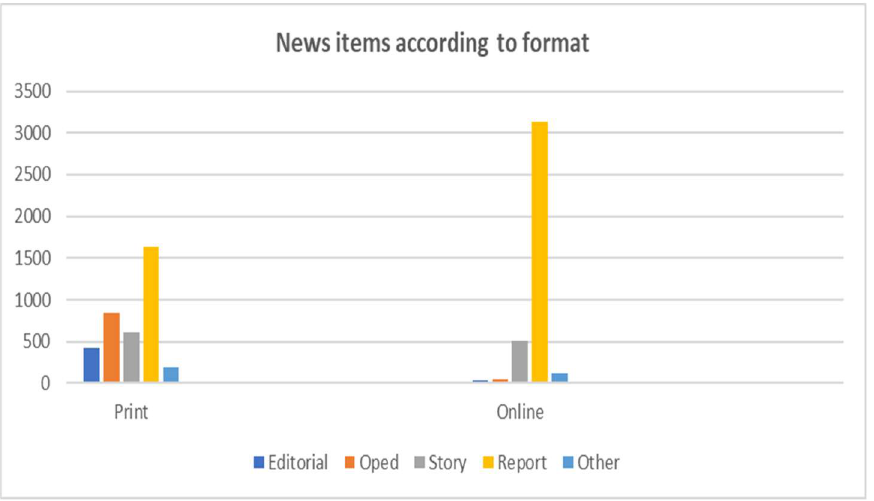
Figure 3. News items according to format.